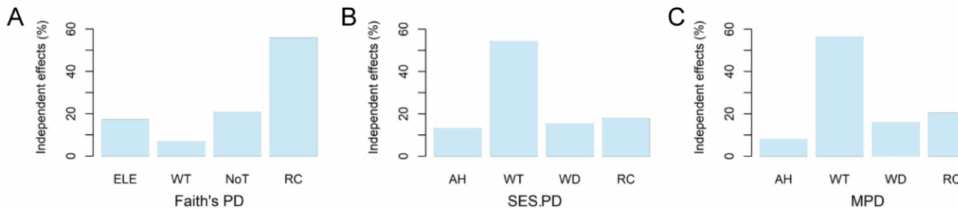
Figure 4. The independent contributions of selected environmental variables to the variation of different phylogenetic structure indices based on hierarchical partitioning analyses. ( A ) Faith’s PD; ( B ) SES.PD; ( C ) MPD. Details of the abbreviations are as follows: SES.PD, standardized effect size of Faith’s PD; MPD, mean pairwise phylogenetic distance index; SES.MPD, standardized effect size of MPD; ELE, elevation; WT, water temperature; NoT, the number of trees; RC, rock cover; AH, air humidity; WD, water